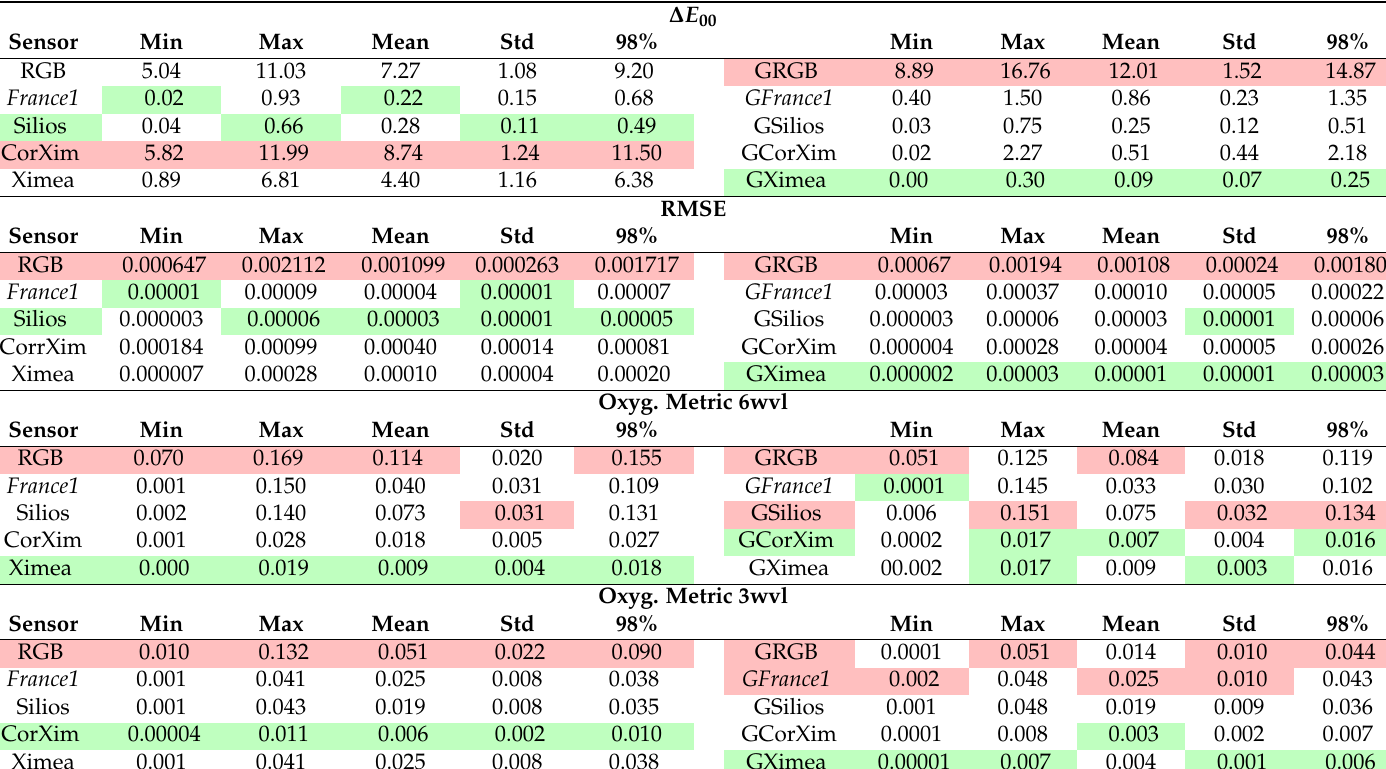
Table 5. Statistical results (minimum, maximum, mean, standard deviation, 98%) for all sensors for ∆ E 00 (top), RMSE (2nd from top), ∆ Oxy 6wvl (3rd from top) and ∆ Oxy 3wvl (bottom). All values are based on skin simulation set as training and skin reflectance set as